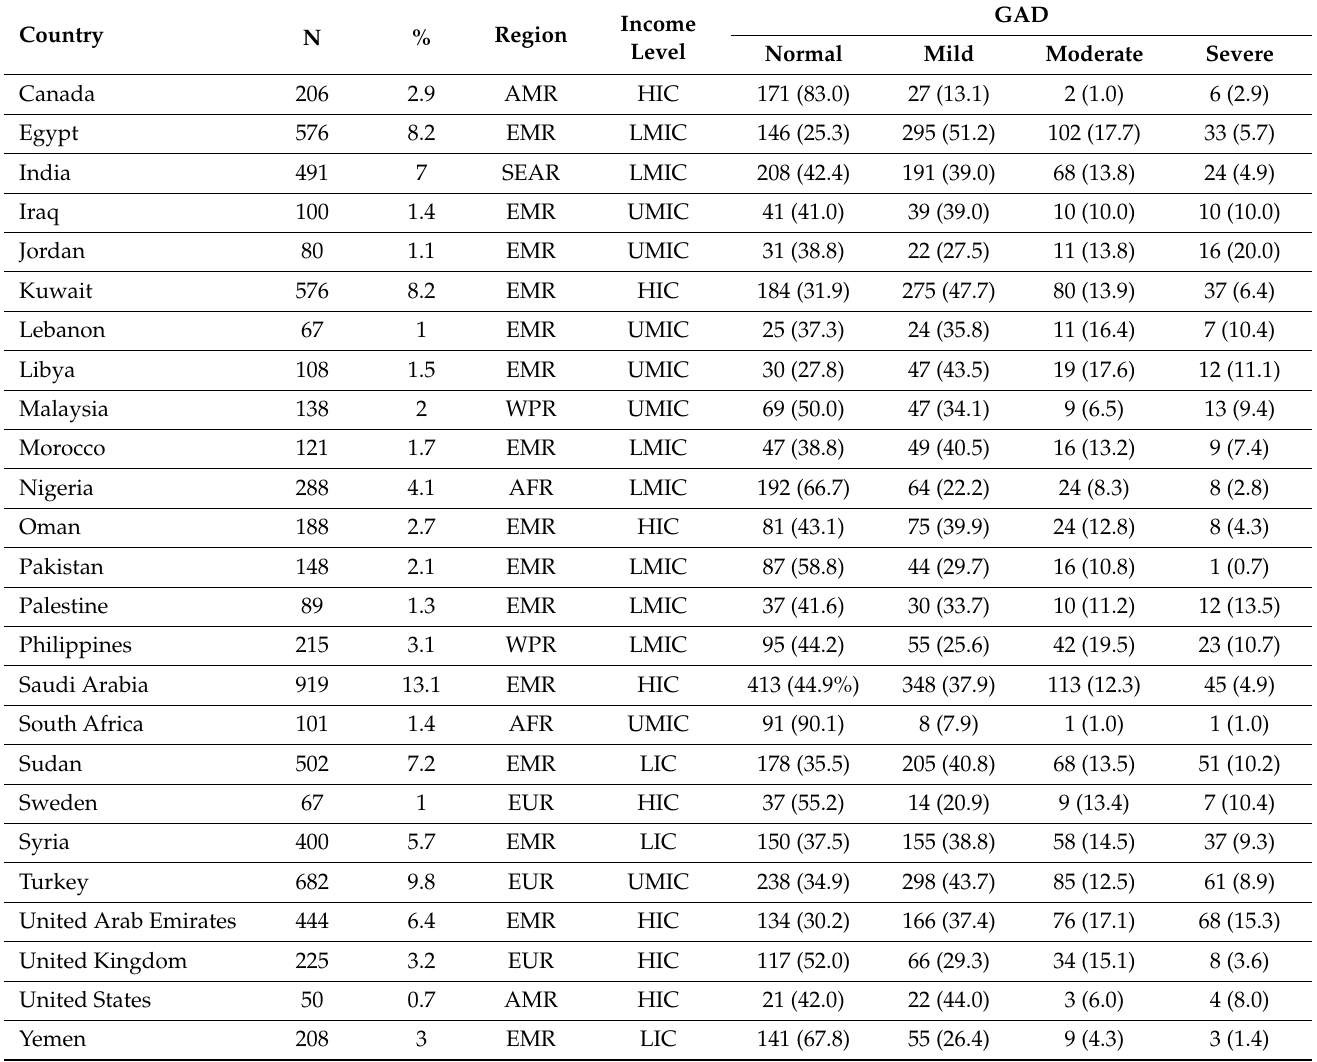
Table A1. Number of participants by country ( n =